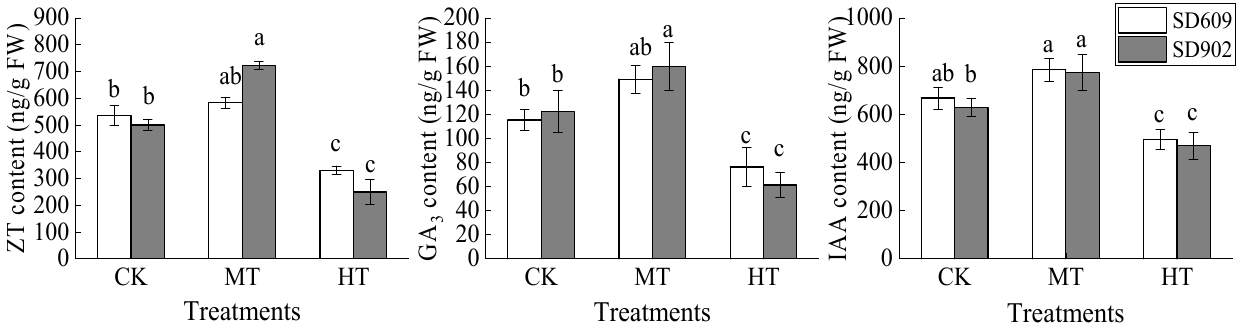
Figure 6. Effects of different root zone temperatures on root hormone contents of SD609 and SD902. CK: 24 ◦ C, MT: 30 ◦ C, HT: 36 ◦ C (root zone temperature). Notations above bars of a, b, c, and d indicate homogeneous groups ( α = 0.05).